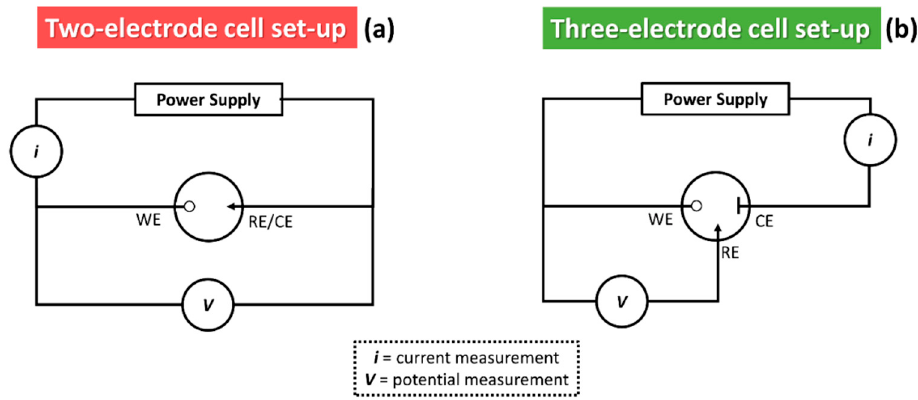
Figure 2. Schematic representation of ( a ) two ‐ electrode and ( b ) three ‐ electrode cell configurations for a Li ‐ ion battery during the charging process.